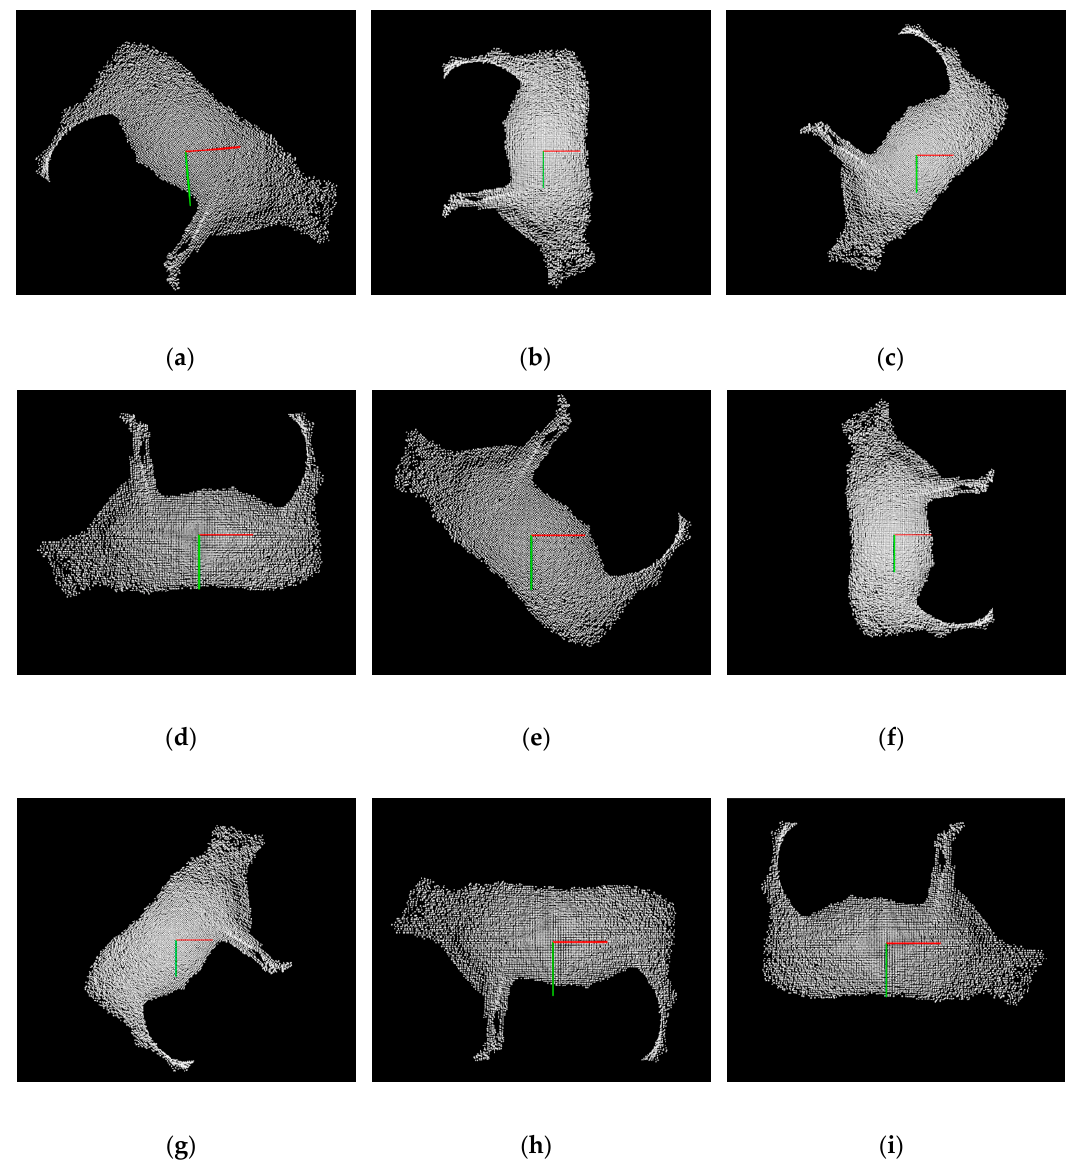
Figure 8. Transformation results of a single point cloud. ( a ) Rotation result with clockwise 45°; ( b ) rotation result with clockwise 90°; ( c ) rotation result with clockwise 135°; ( d ) rotation result with clockwise 180°; ( e ) rotation result with clockwise 225°; ( f ) rotation result with clockwise 270°; ( g ) rotation result with clockwise 315°; ( h ) horizontal mirror result; ( i ) vertical mirror result.